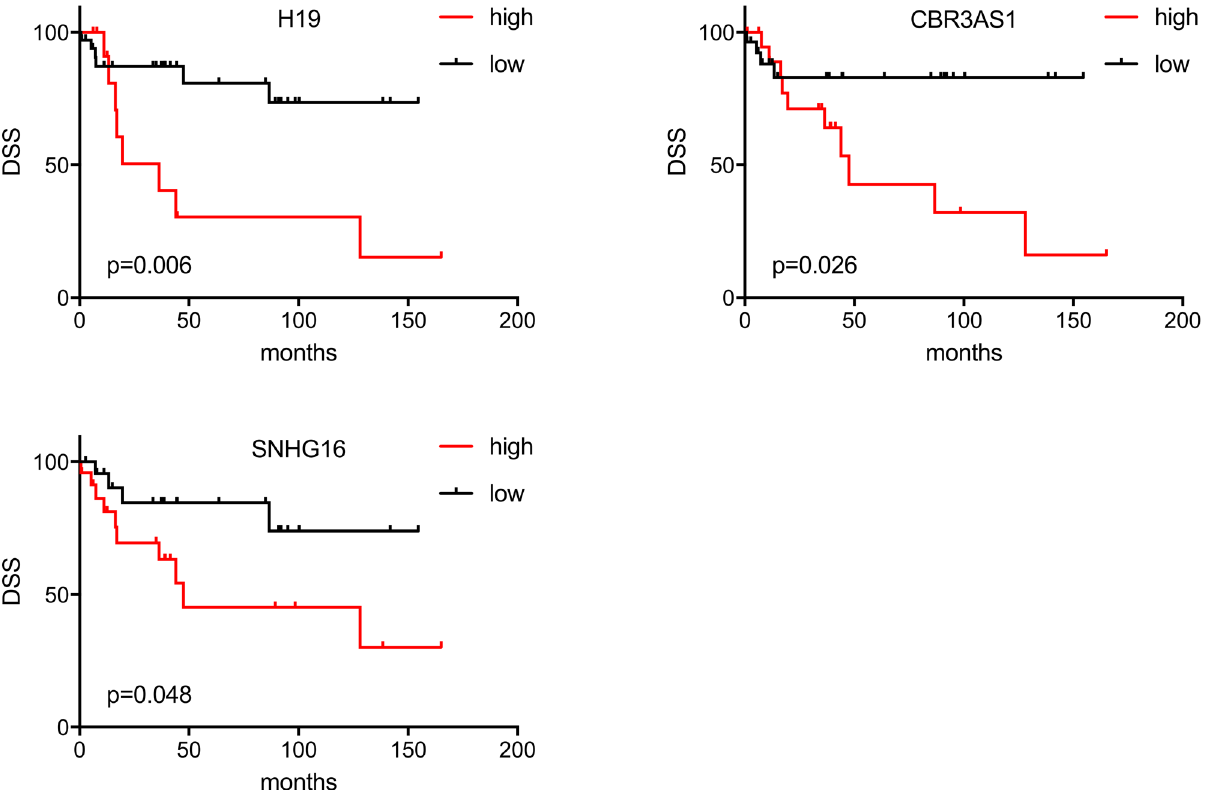
Figure 3. Kaplan Meier plots of lncRNAs allowing a significant risk stratification ( p < 0.05) based on high and low transcript level expression in the Mannheim cohort. DSS disease specific